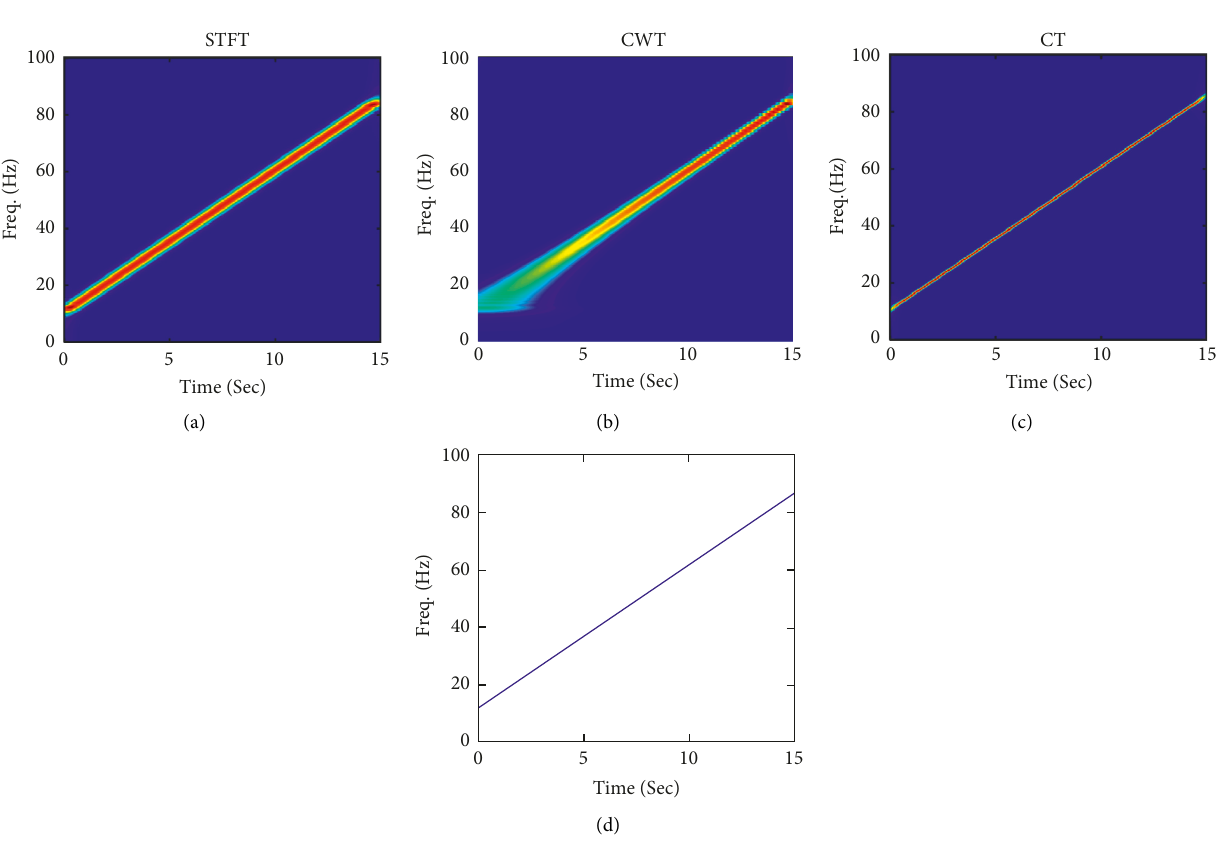
Figure 1: Comparison of time-frequency diagram obtained by different methods. (a) Short time Fourier transform. (b) Continuous wavelet transform. (c) Chirplet transform. (d) Theoretical time-frequency